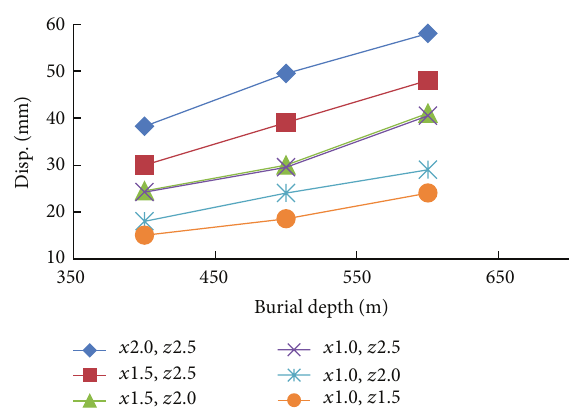
Figure 9: Key point displacement versus burial depth under varying lateral pressure coefficient.